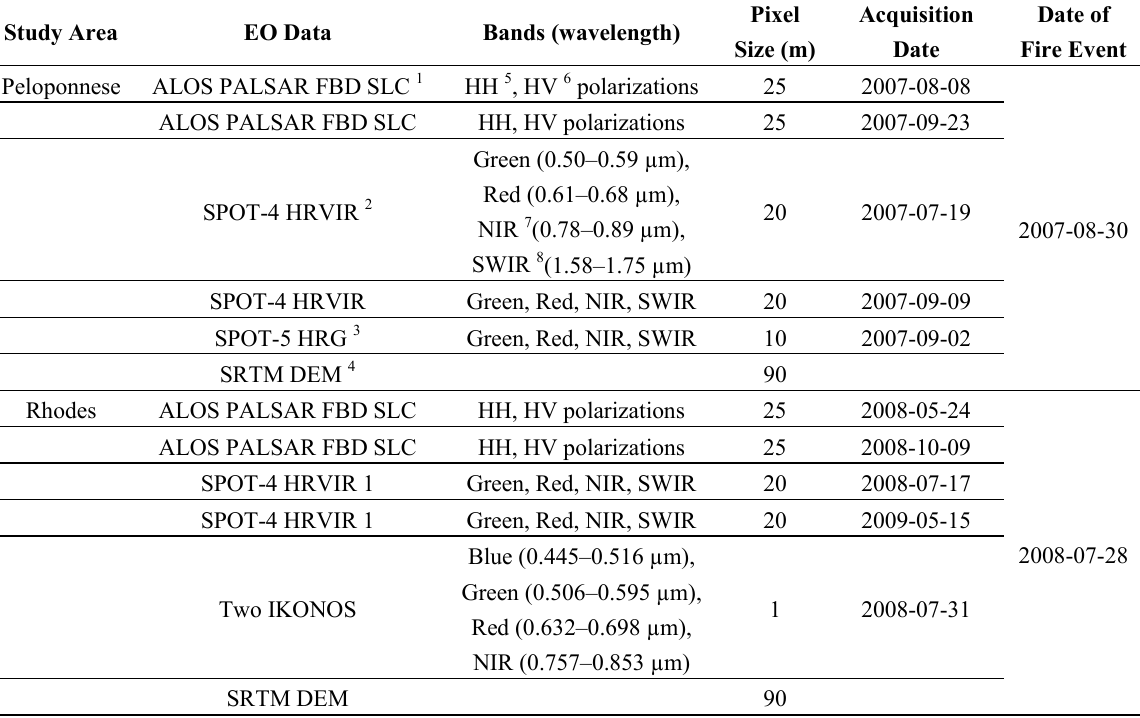
Table 1. List of the available Earth Observation (EO) data for the Peloponnese and Rhodes Island study